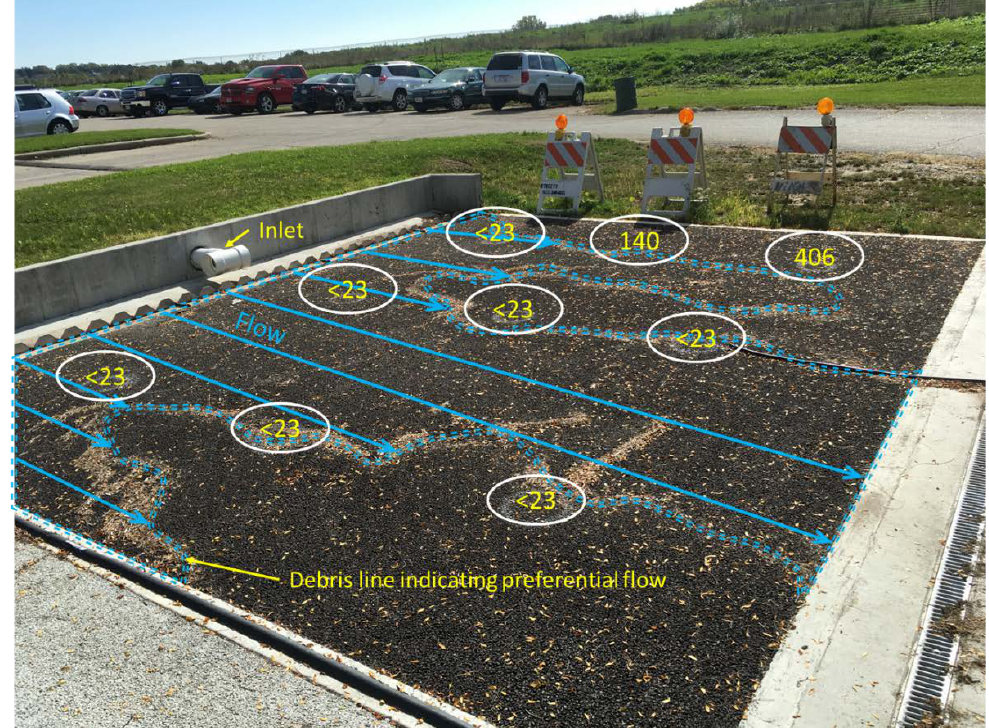
Figure 6. Infiltration values (cm/h) for nine discrete test locations on 21 June 2017. Average surface infiltration rate was 79 cm/h.